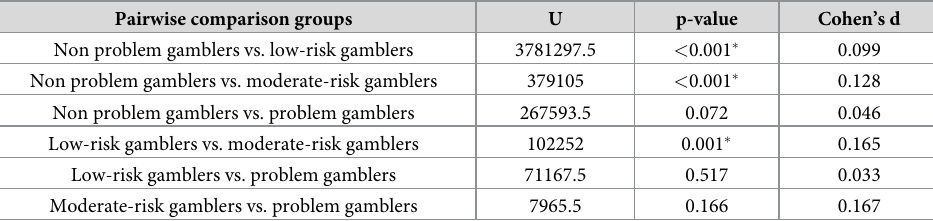
Table 3. Pairwise comparisons of the effects of problem gambling on other microtransaction spending. Effects that are significant at the p < 0.008 level are marked with a � . Pairwise comparison groups